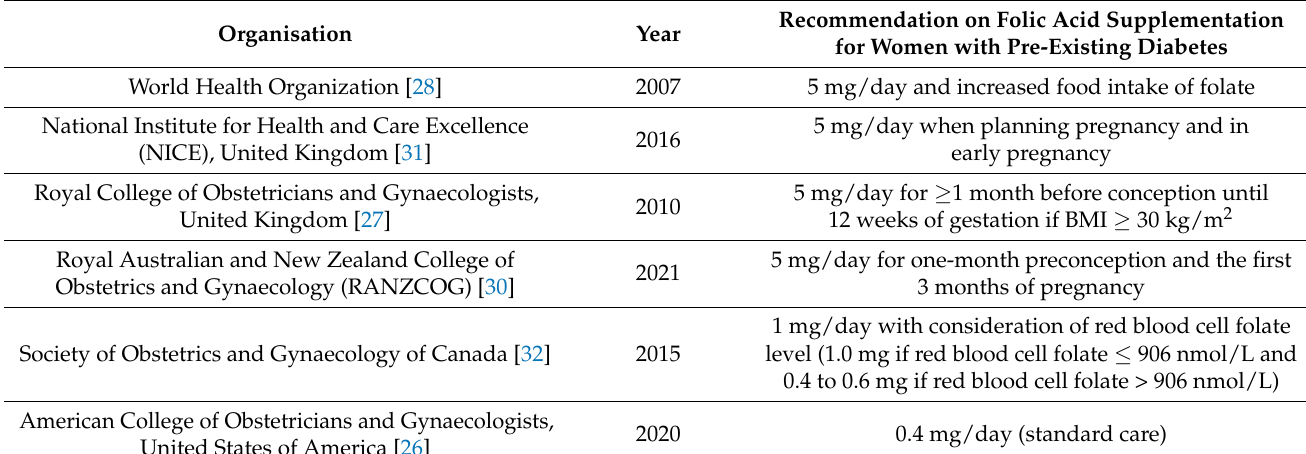
Table 1. International recommendations for folate supplementation in women with pre-existing